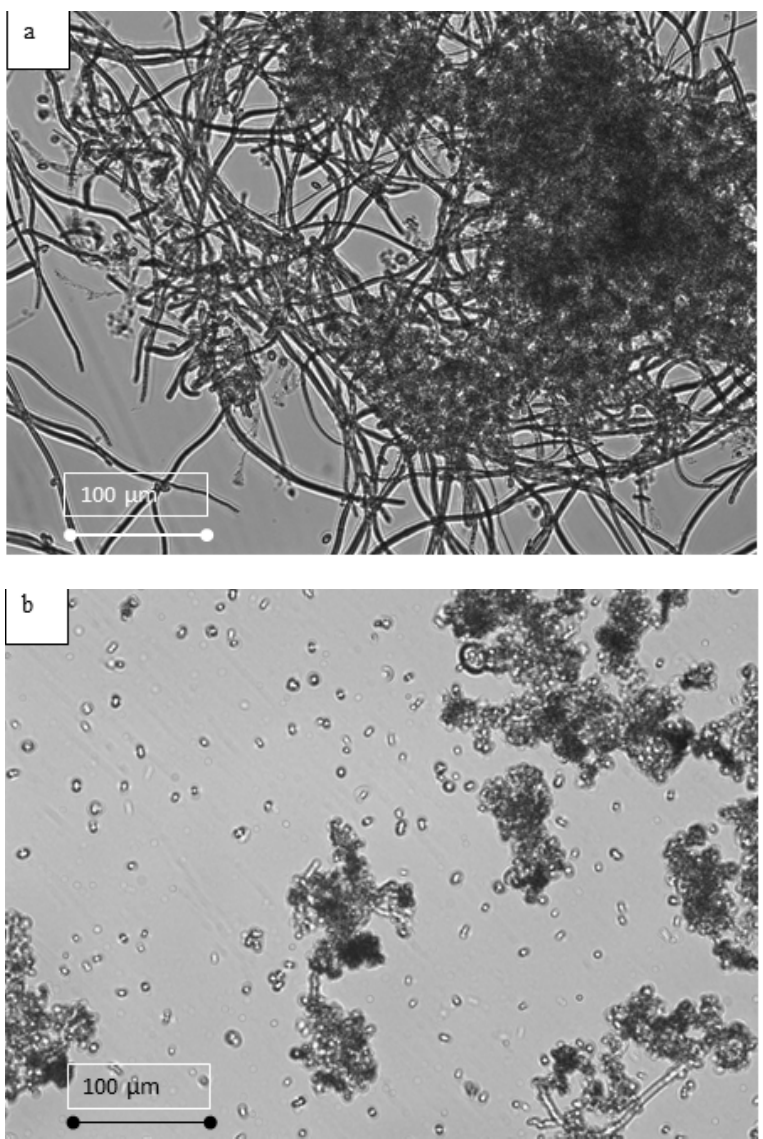
Figure 7. Microscopic images representing the morphology of C. vulgaris in ( a ) MPBR and ( b ) EK-MPBR.